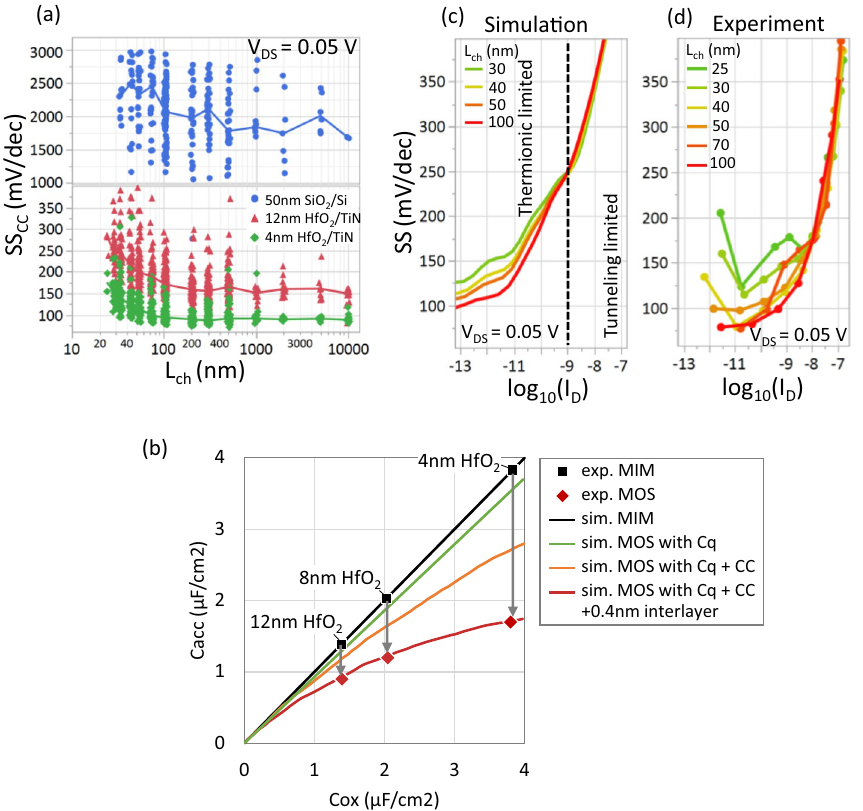
Figure 4. ( a ) Scatter plot (with median line) of SS CC versus L ch for the three different oxides. While SS improves with lower EOT, the degradation and scatter for short channel devices are attributed to electrostatic potential fluctuations caused by non-uniform thickness of MoS 2 in the contact and channel regions. ( b ) Experimentally measured maximum accumulation capacitance from MOScap (C acc ) versus MIMcap capacitance (C ox ). Systematically, the C acc is lower than C ox corresponding to an additional 1 nm CET over the measured EOT. Simulations show this is caused by the quantum capacitance Cq (MoS 2 having lower DOS than metal), the impact of the charge centroid (CC) further away in MOS than MIM, and additionally due to 0.4 nm of water or carbon residues stuck at the HfO 2 /MoS 2 interface during transfer. Qualitative comparison between ( c ) simulated and ( d ) experimental SS versus log (I D ) for different L ch. The simulated SS is for a uniform 3 monolayers MoS 2 with SBH = 0.45 eV. Two transport regimes at the contacts– thermionic emission and tunneling through the SB are identified. In the thermionic regime, the relative increase of field in the channel from the source/drain Schottky contacts degrades gate control for short L ch devices. In the tunneling regime, the nearly equal tunneling lengths for the different L ch results in a similar but degraded SS compared to the thermionic